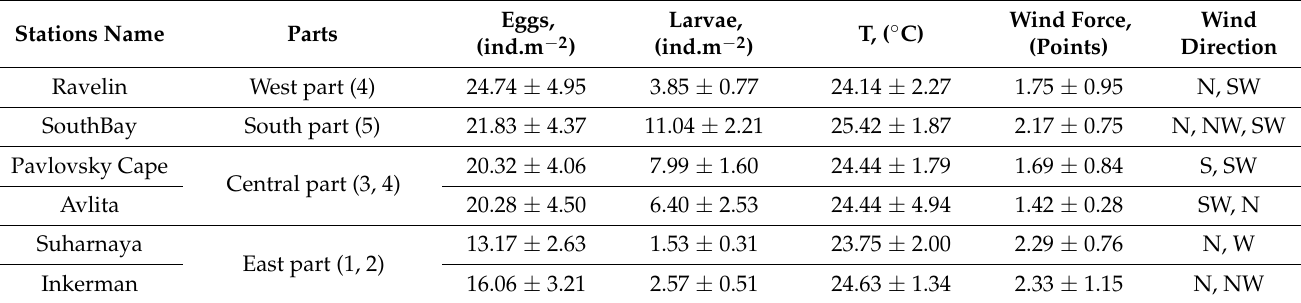
Table 1. Average ( ± SD) values for ichthyoplankton abundance and hydrometeorological characteris- tics and their standard deviations in the Sevastopol Bay in the summer of 2012–2021.